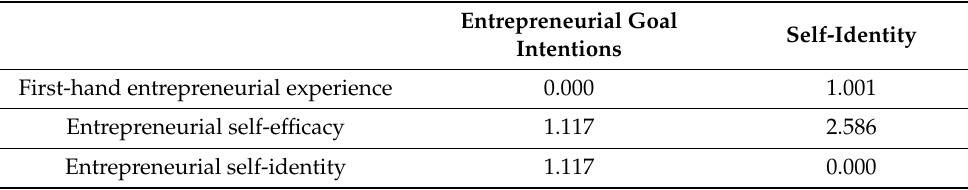
Table 4. Variance inflation factors.